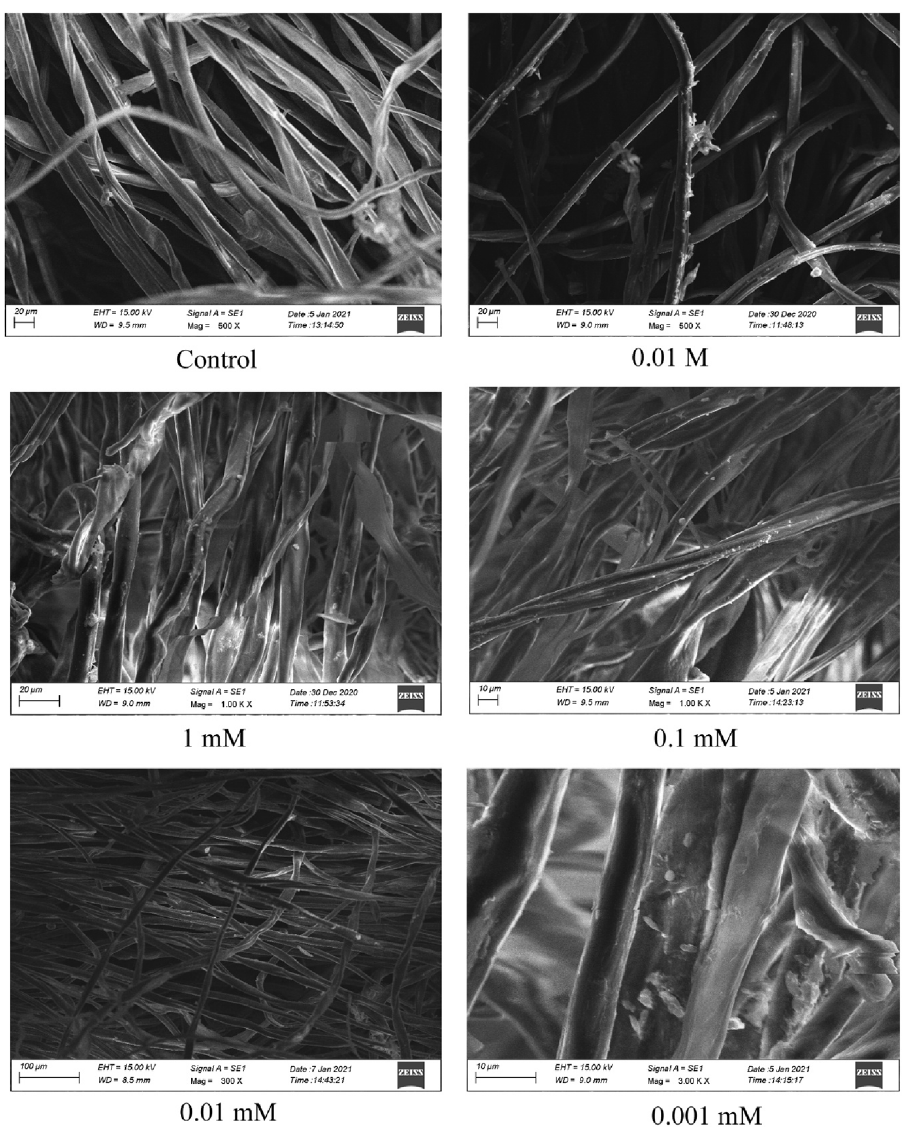
Figure 10. SEM image of gold nanoparticle dyed cotton material at various